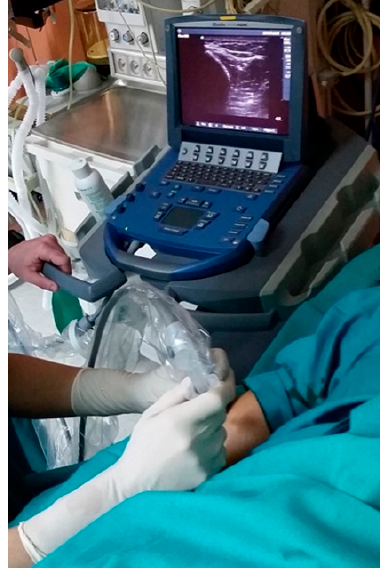
Figure 2. US-guided plasma rich in growth factors injection for the radial nerve. The procedure was performed in sterile conditions in an outpatient setting. The multi-frequency linear probe was aligned with the long axis of the radial nerve, and a 22-gauge needle (25 mm) was inserted into the radial nerve. The accuracy of platelet-rich plasma (PRP) infiltration was confirmed by direct visualization by US imaging.